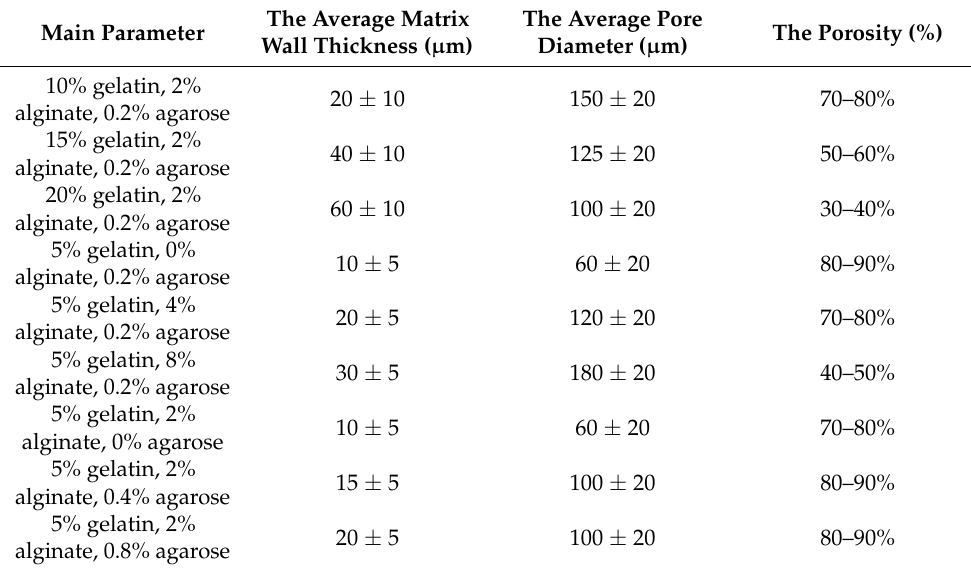
Table 2. Concentrations of polymer